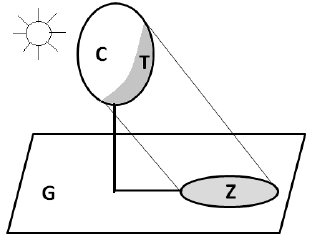
Figure 2. The four scene components used in the geometric optical (GO) model. C is the sunlit tree crown; T is the shaded tree crown; G is the sunlit background; and Z is the shaded background. The canopy structure parameters listed in Table 1 for the stands are derived based on the field measurements of the DBH and tree height of every individual tree in the stands, and the allometric relationships between DBH or tree height. Parameter h1 and h2 must represent the structure of the dominant canopy layer. Therefore, we used the mean height minus s.d. to derive h1 and the mean height plus s.d. to derive h2 . FAVD is calculated by dividing LAI by the crown volume, by treating the tree crown as an ellipsoid. Table 1. Canopy structure parameters required for the GORT model to simulate canopy reflectance.